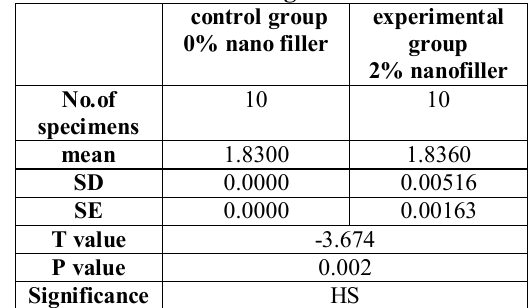
Table 1: impact strength in (KJ/mm²).